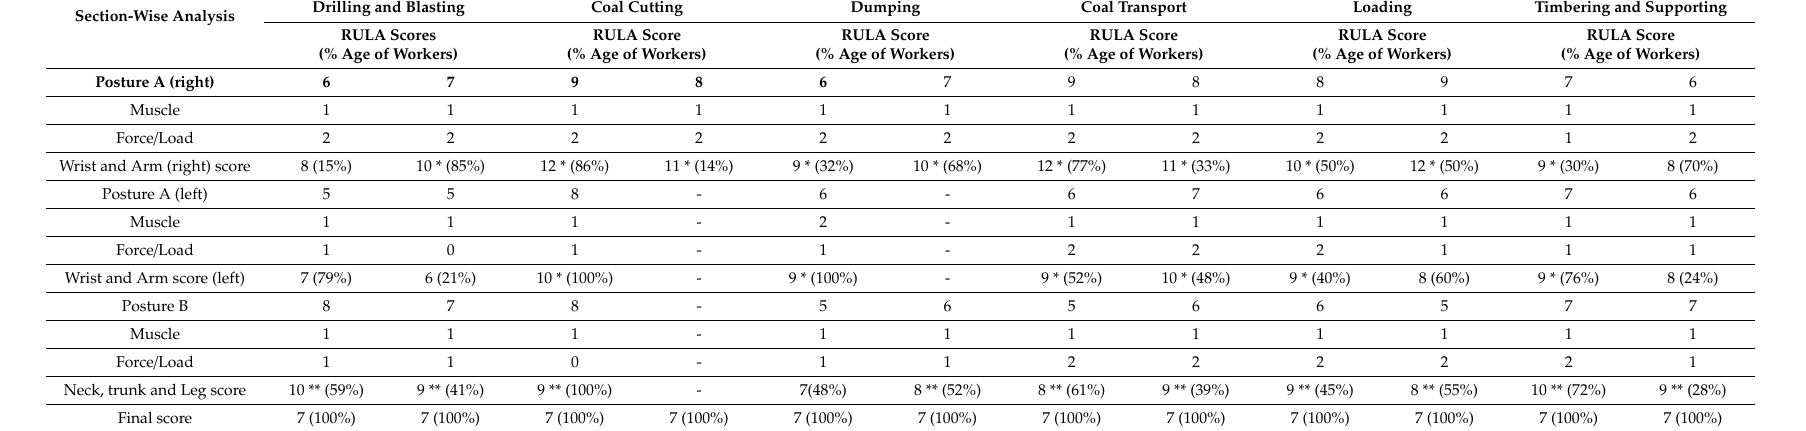
Table 7. Analysis derived from using Rapid Upper Limb Assessment (RULA) assessment